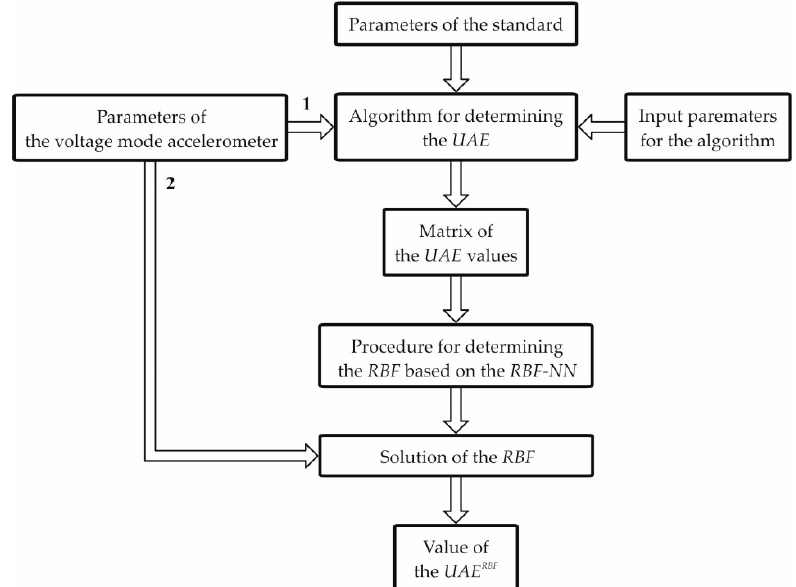
Figure 1. Block diagram of the procedure intended for determining the radial basis function ( RBF ) and the value of absolute dynamic error ( UAE RBF ).